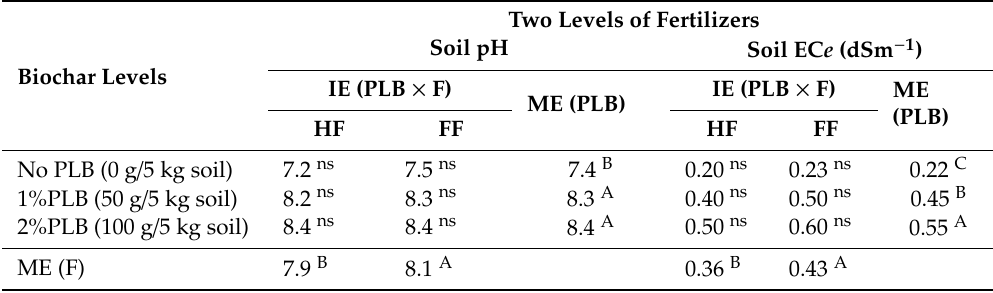
Table 2. Effect of three rates of the leaf biochar (0, 1, and 2%) under half (HF) and full fertilizer (FF) on the soil pH and electrical conductivity (EC).